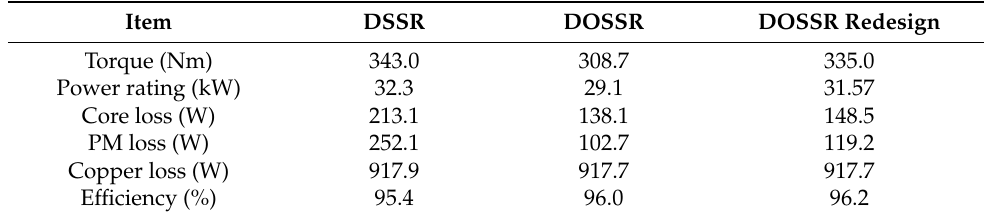
Table 5. Losses and efficiency for the DSSR motor and the DOSSR motor at base